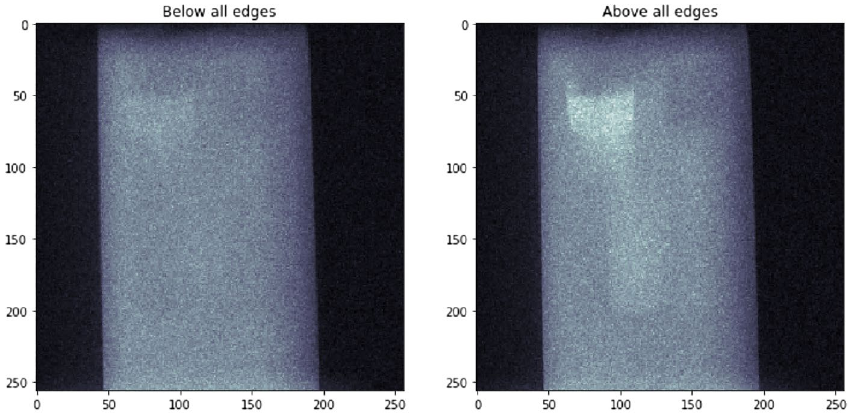
Figure 5. Projections of the phantom taken at energies A (below all edges, left) and D (above all edges, right) with the flat field correction.